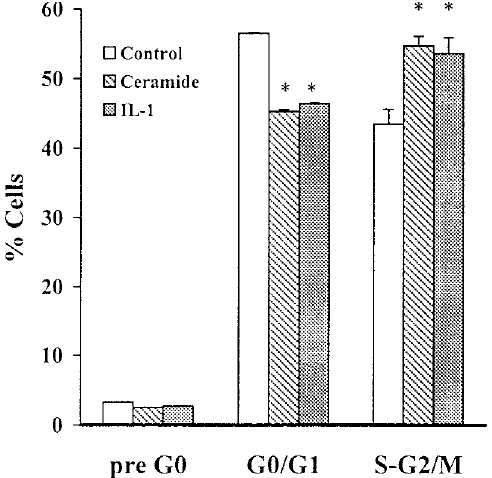
FIG. 5. Effects of IL-1 (30ng/ml) and ceramide (30 m M) on the cell cycle distribution of IEC after 24h of treatment. Histo- gram-related nuclear DNA contents were measured by flow cytometry as described in ‘Materials and methods’. The sum of G 0 /G 1 and S–G 2 /M phases is normalized to 100% ( n =